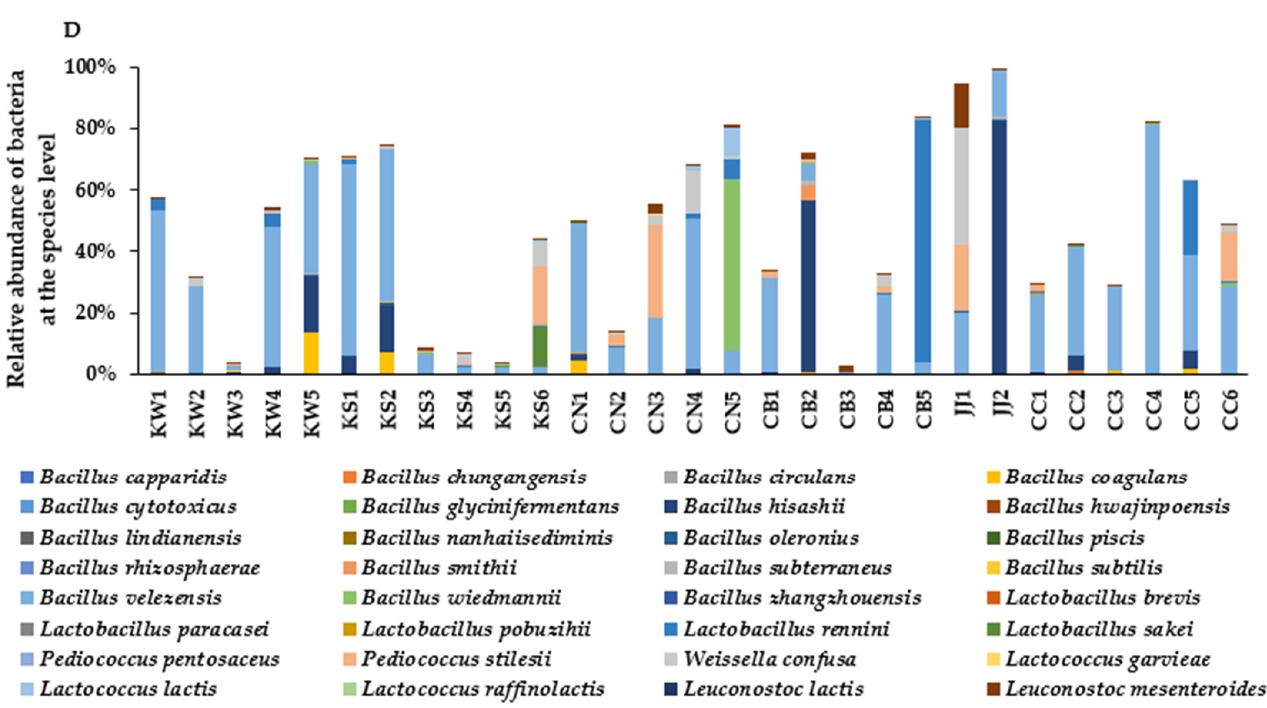
Figure 2. The bacterial composition of traditionally made doenjang (TMD). ( A ) Relative abundance at the class level of all bacteria. ( B ) Relative abundance at the family level of all bacteria. ( C ) Relative abundance at the genus level of all bacteria. ( D ) Percentage of Bacillus and Lactobacillus spp. at the species level. TMD samples from Chonbuk (CB), Chonnam (CN), Kyungsang (Kyungbuk + Kyungnam) (KS), Kangwon (KW), Chungcheung (Chungbuk + Chungnam) (CC), and Jeju island (JJ).